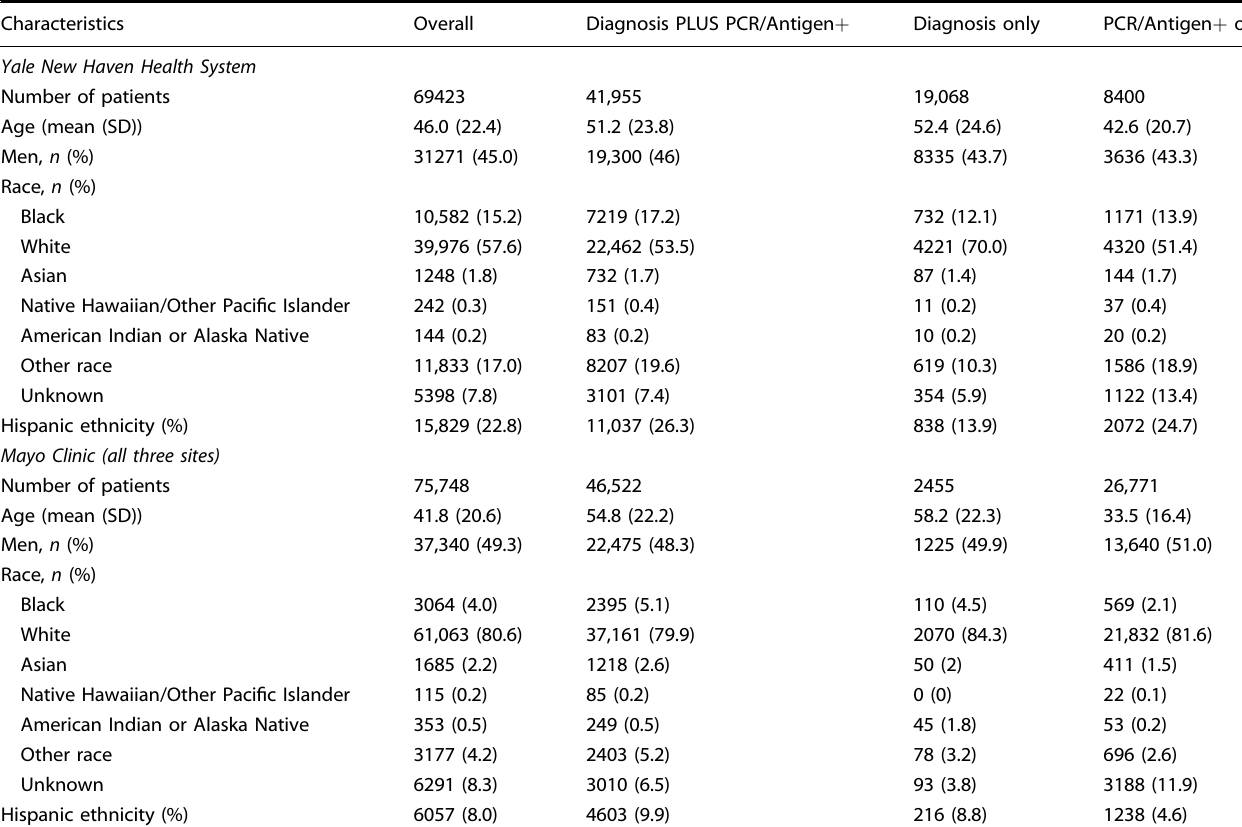
Table 1. Characteristics of patients across mutually exclusive computable phenotypes from the Yale New-Haven Health System and Mayo